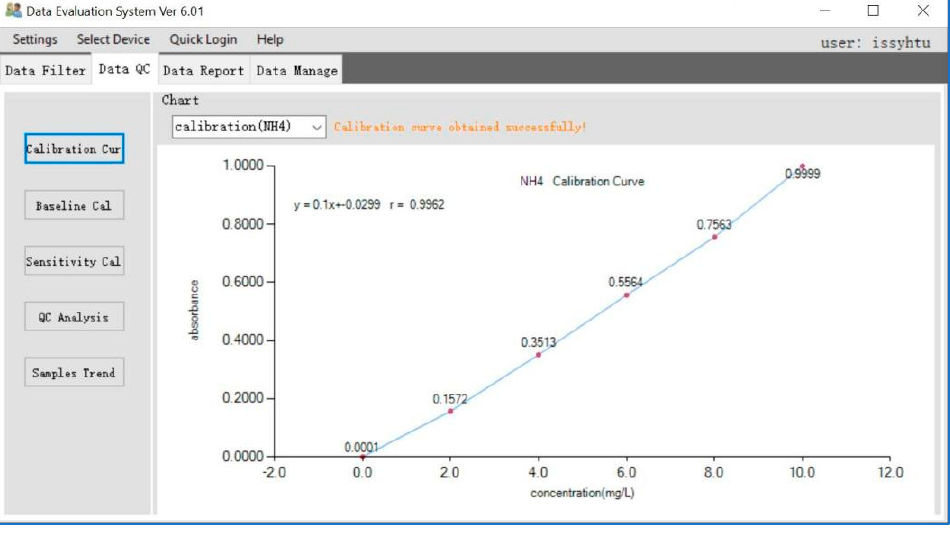
Figure 11. Detection calibration curve.